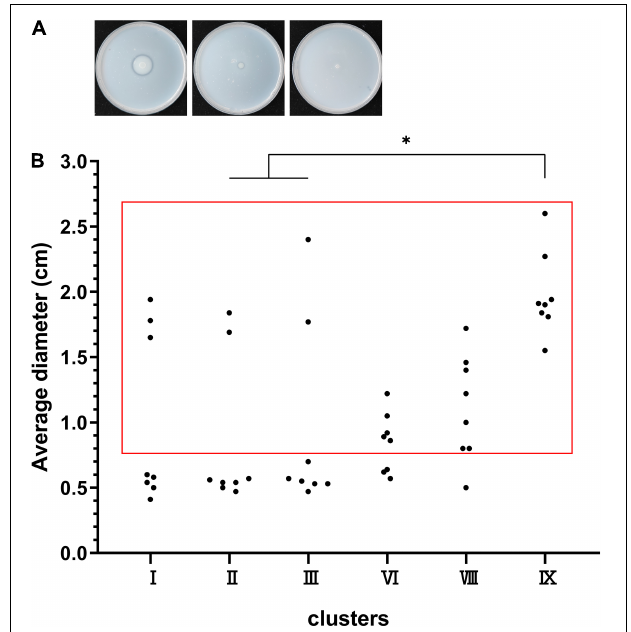
FIGURE 6 | Protease production capacity of clusters I, II, III, VI, VIII, and IX. (A) The left panel shows the lysis loop of a high-protease-producing strain, the middle shows the lysis loop of a low-protease-producing strain, and the right shows no loop of a non-protease-producing strain. (B) The dots in the red box represent the protease-producing strains, and the dots outside the red box represent the non-protease-producing strains. * P < 0.05 means higher proteolytic activity of cluster IX compared to clusters II and